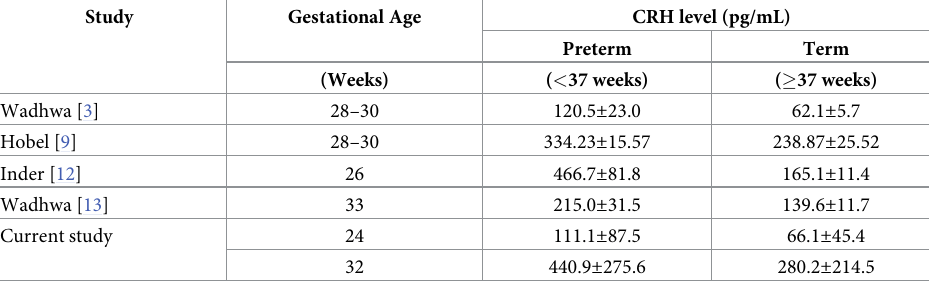
Table 4. CRH levels by RIA in unselected populations and in the current